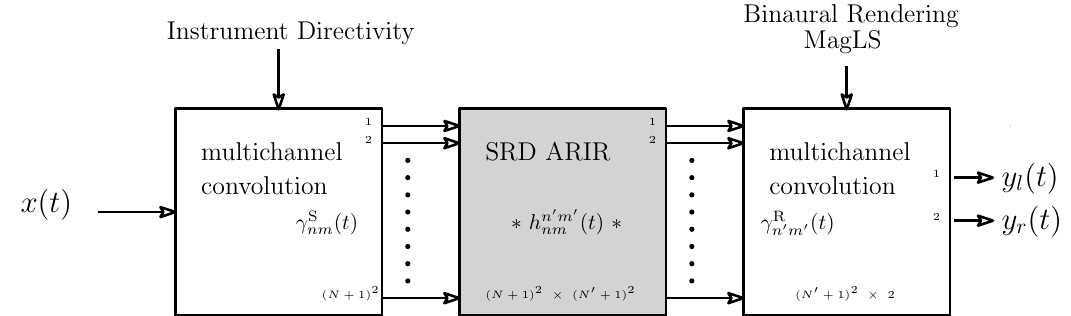
Figure 1. Auralization scenario using the source and receiver directional (SRD) ARIR (in the Ambisonics domain). Here, x ( t ) is the source signal, h n (cid:48) m (cid:48) nm ( t ) is the SRD ARIR, and γ S nm ( t ) and γ R the directional impulse responses of the source and receiver, e.g., ear directivity,